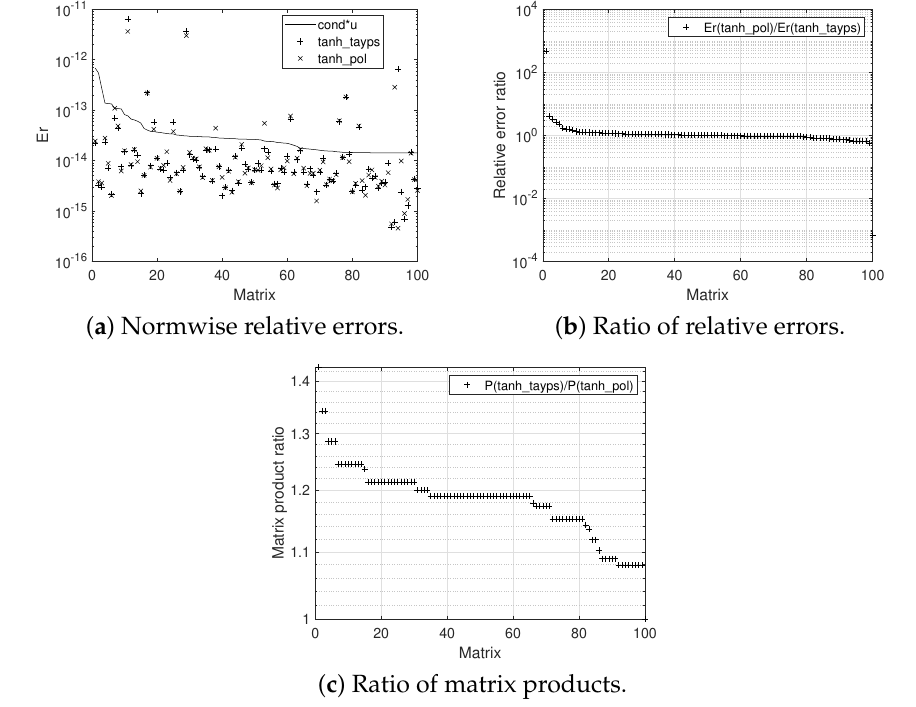
Figure 4. Experimental results for Test